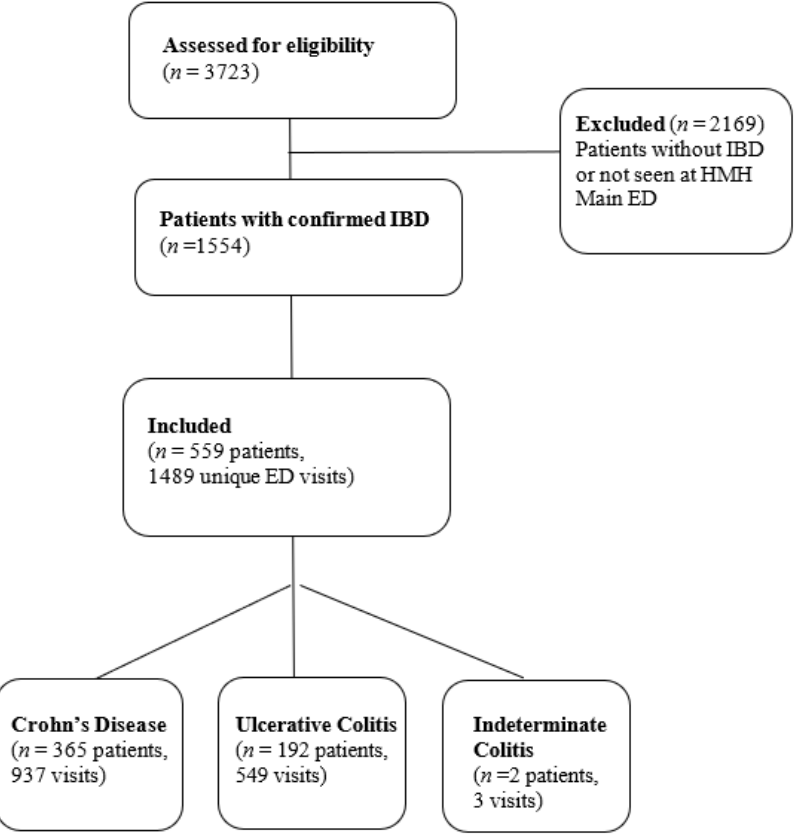
Figure 1. Consort diagram: frequency of visits, CT scans, and steroid use in inflammatory bowel disease patients seen in the emergency department: a retrospective cohort study.